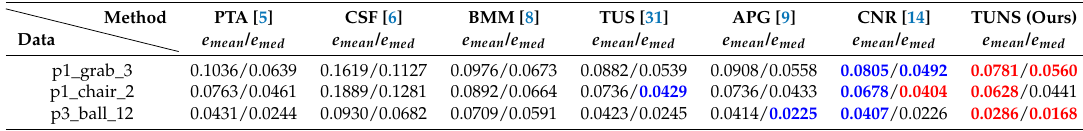
Table 2. Quantitative evaluation on UMPM sequences. The table reports the mean error e mean and median error e med of 3D reconstructions for the following NRSfM baselines PTA [5], CSF [6], BMM [8], TUS [31], APG [9], CNR [14]; and our proposed method TUNS. For each sequence, the best and the second-best results of, both mean and median errors, are shown in red and blue , respectively.